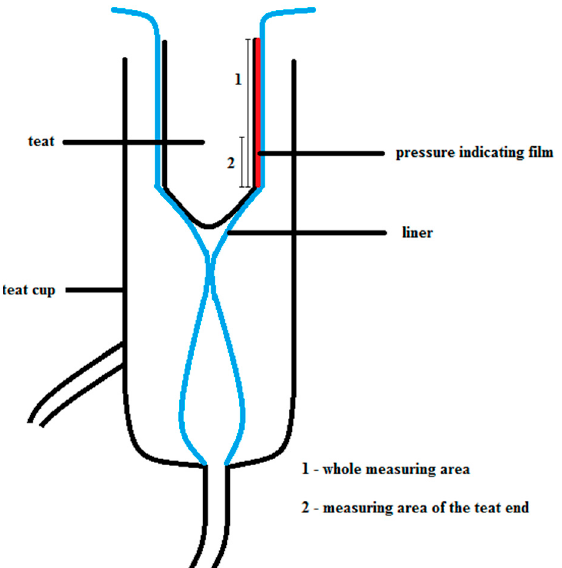
Figure 2. Schematic drawing of the position of the teat equipped with the pressure-indicating film.